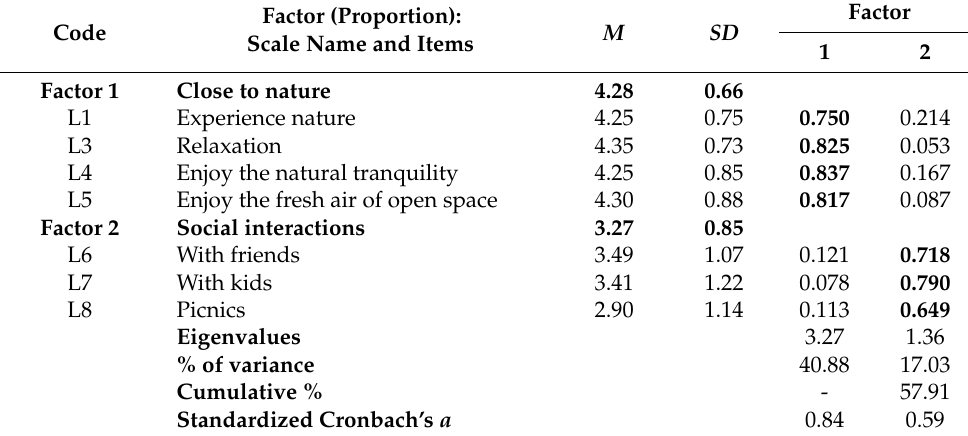
Table A1. Summary results of exploratory factor analysis for leisure motivations ( n = 605, 2019 sample).